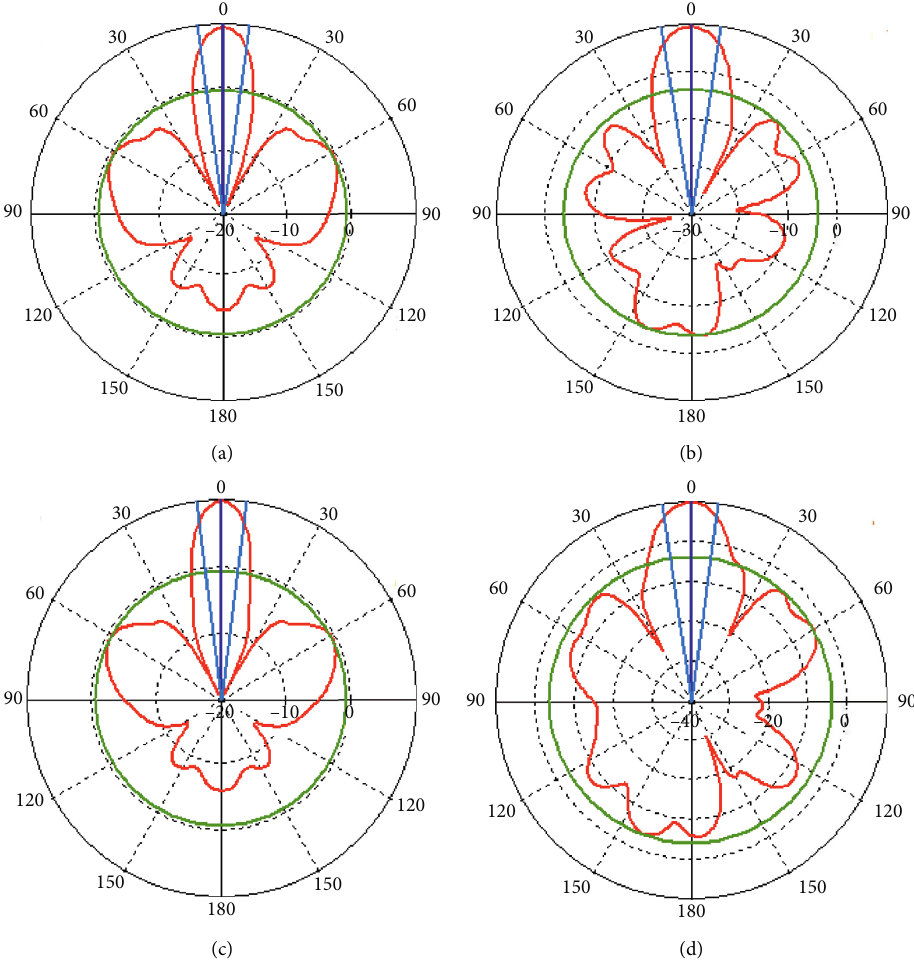
Figure 7: Simulated radiation patterns at the frequency of 14GHz for (a) E-plane and (b) H-plane and at 14.2GHz for (c) E-plane and (d)